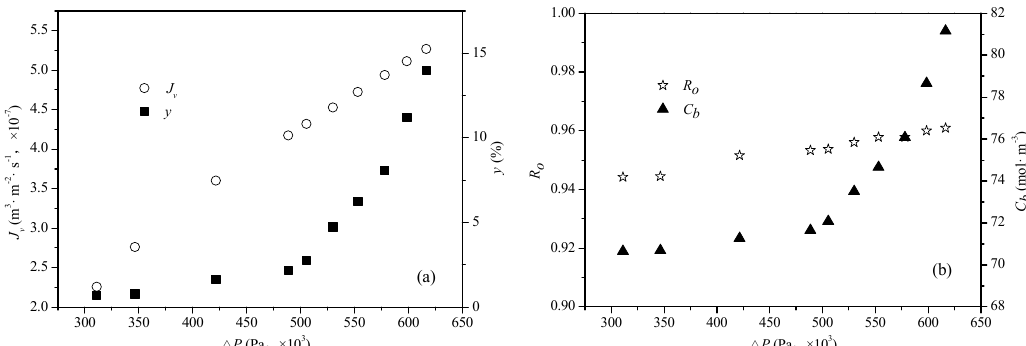
Figure 4. Influence of transmembrane pressure on RO process. ( a ) Solvent flux and recovery vary with transmembrane pressure, feed solution concentrate ( C f ) = 70.17 mol·m − 3 , pH = 6, T = 306 K; ( b ) Solute rejection and retentate solution concentration vary with transmembrane pressure, feed solution concentrate ( C f ) = 70.17 mol·m − 3 , pH = 6, T = 306 K.